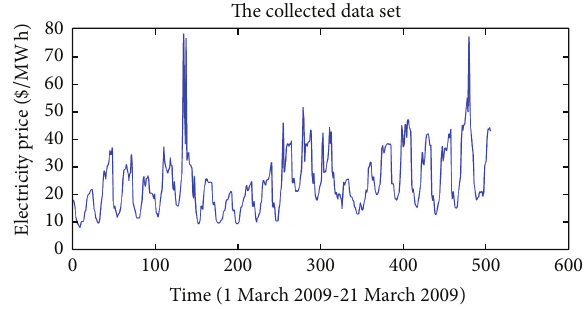
Figure 3: The collected